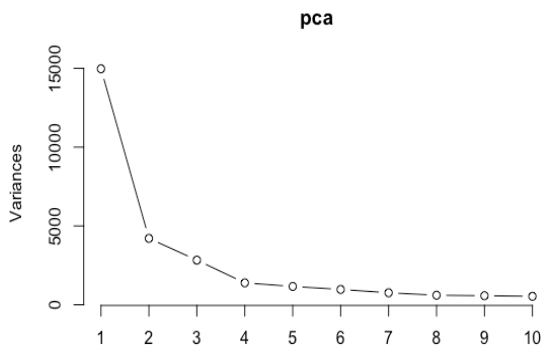
Fig.7. Apply PCA for the dimentionality reduction